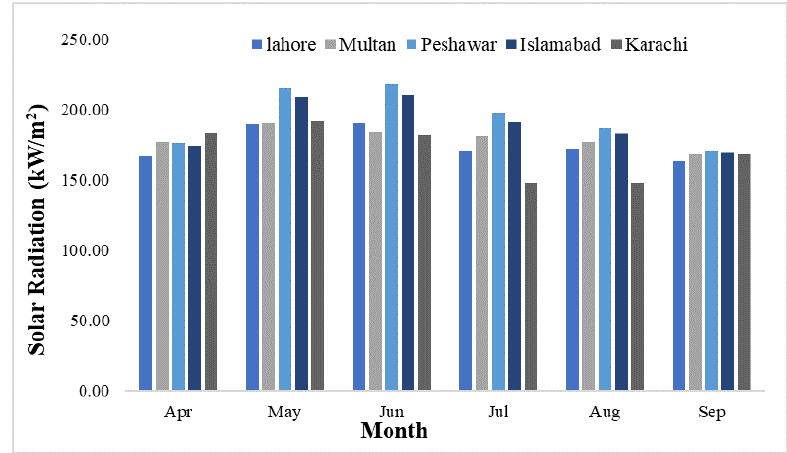
Figure 4. Monthly solar radiations in